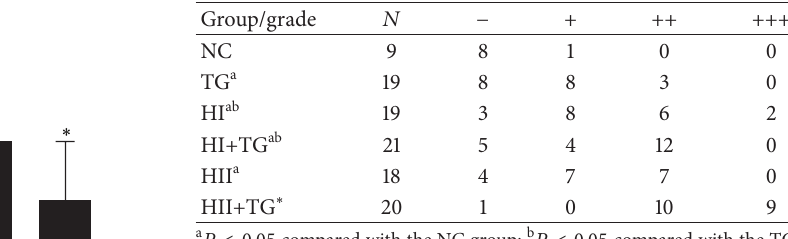
Table 3: Grades of thyroid pathological features in EAT rats.